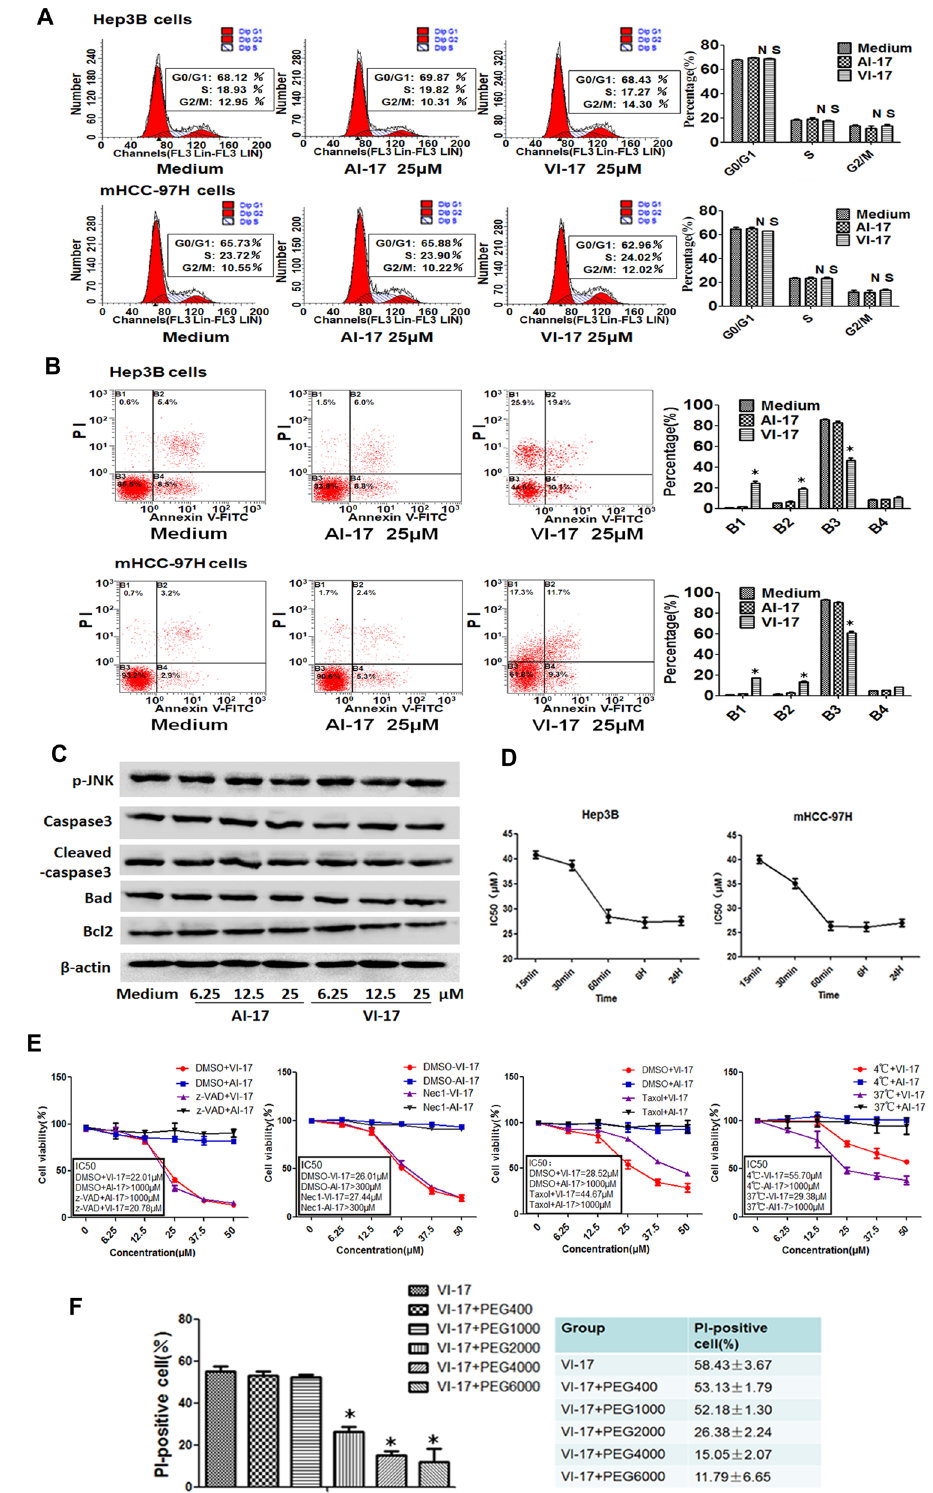
Figure 3. Taxol attenuated VI-17-elicited cytotoxicity on HCC cells. (A) Flow cytometric analysis for the effect of VI-17 on cell cycle. (B) Flow cytometric analysis for the effect of VI-17 on cell apoptosis. (C) Western blot analysis for expression of apoptotic molecules. (D) IC50 values of VI-17 on hepatoma cells at indicating time points according to MTT assays. Data are expressed as Mean ± SD of three independent experiments in triplicates. *p < 0.05. (E) MTT assays for the effects of z-VAD-fmk, necrostatin-1, taxol and low temperatures on VI-17 induced cell death of Hep3B cells. (F) Analysis for the ratio of PI-positive cell under PEGs pretreatment in VI-17-treated Hep3B cells. Data are expressed as Mean ± SD of three independent experiments in triplicates. *p <